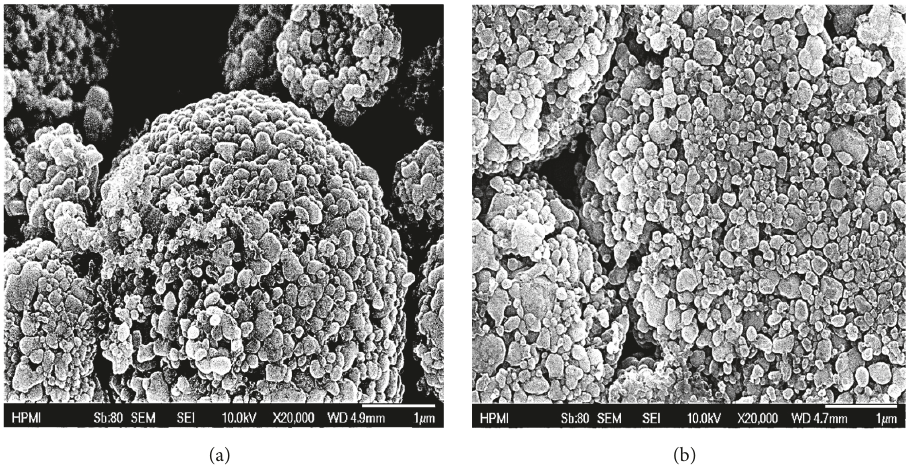
Figure 2: SEM Images of LFP electrode: (a) uncalendered electrode; (b) calendered